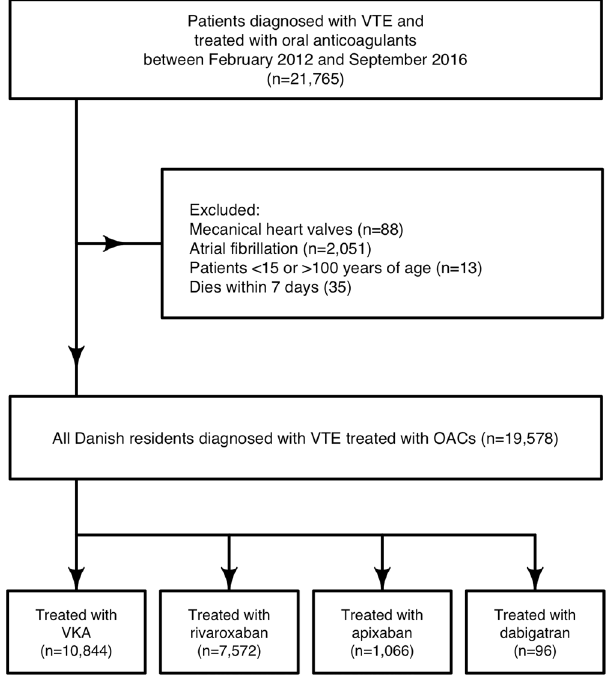
Figure 1. Selection of study cohort. Flow chart of selection process for the study population in the period between February 2012 and September